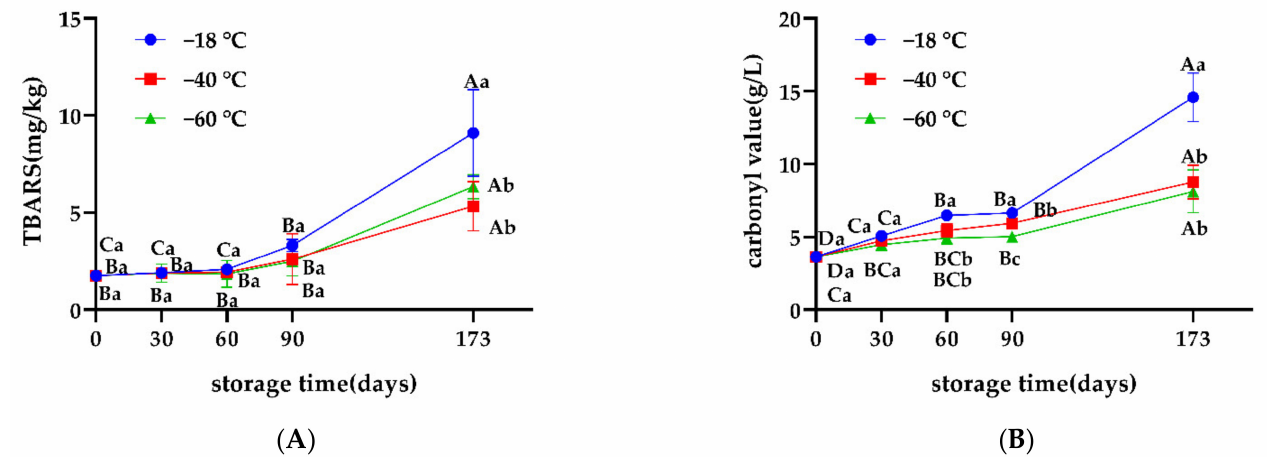
Figure 6. ( A ) Effects of different freezing storage temperatures on TBARS of snowflake beef ( n = 4); ( B ) Effects of different freezing storage temperatures on carbonyl values of snowflake beef ( n = 4); abc represents significant differences of different freezing temperatures for the same storage time; ABCD represents significant differences of different freezing times for the same storage